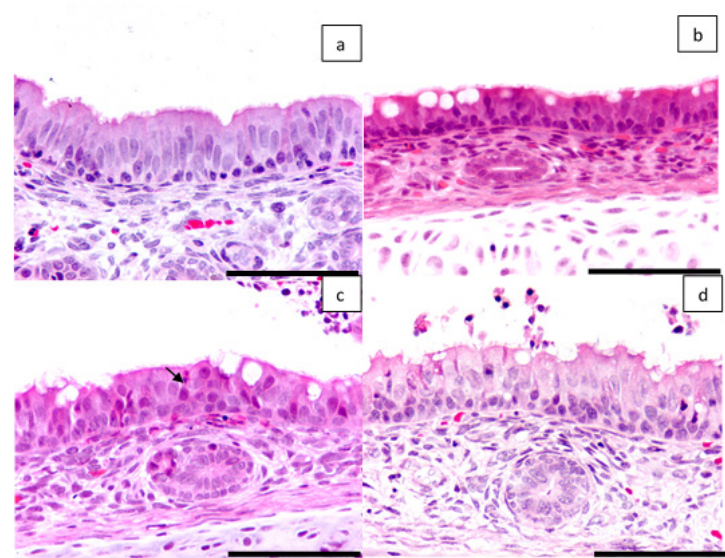
Figure 4. a. Respiratory epithelium of rabbit nasal septum, negative control (group 14). Normal architecture of ciliated epithelium. H&E, 40X. b. Rabbit nasal septum treated with P. multocida + GlcNAc (group 1). The architecture is similar to that seen in Fig. 5a; the number of goblet cells is variable in normal animals. H&E, 40X. c. Ciliated epithelium of the rabbit nasal septum, positive control (group 13). The infiltration of at least 2 or 3 PMNs between the epithelial cells is evident (arrow) as well as the disorganization of the epithelial architecture (dysplasia); some inflammatory detritus accumulates in the lumen. H&E, 40X. d. Rabbit nasal septum treated with P. multocida + GalNAc (group 4). Disorganization of the epithelial architecture due to loss and necrosis of epithelial cells is evident. Desquamating epithelial death cells into the lumen. H&E, 40X. Scale bar: 200